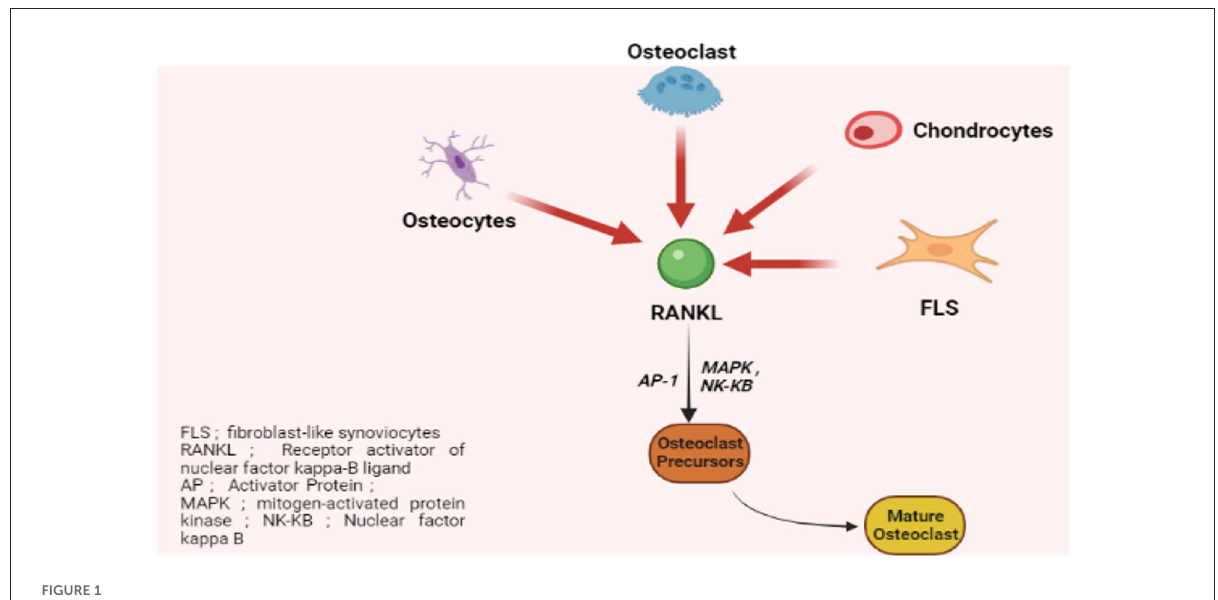
FIGURE1 RANKL-dependent